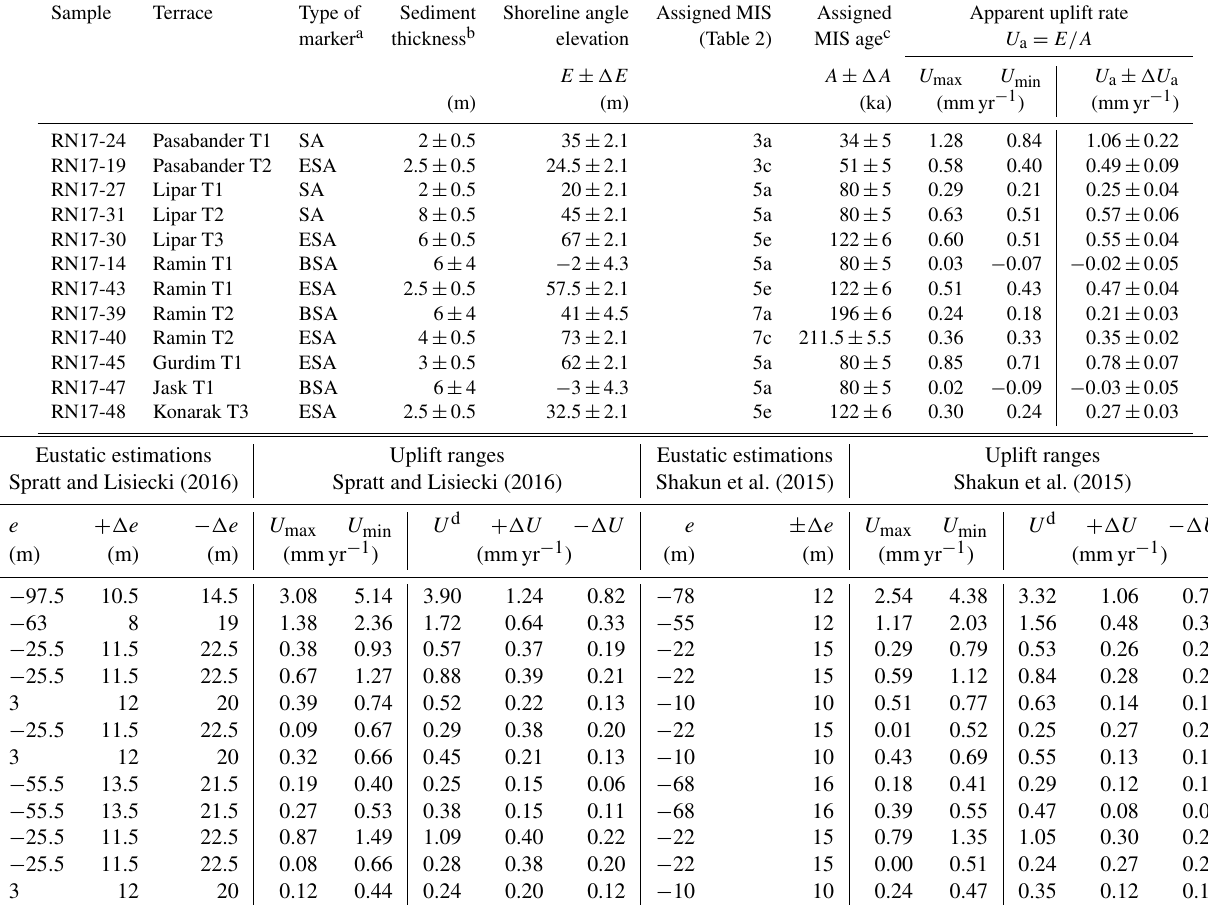
Table 3. Uplift rate calculation at the shoreline angle situated directly northwards of each sample. We present here the results calculated with two sea-level curves (Shakun et al., 2015; Spratt and Lisiecki, 2016), though any other curve could be used in the same manner, following the method described in Sect. 3.3. Notice that these uplift rates are only relevant locally for tilted terraces; thus, a record of spatial uplift rate variation is reported as a graph below each terrace map (Figs.